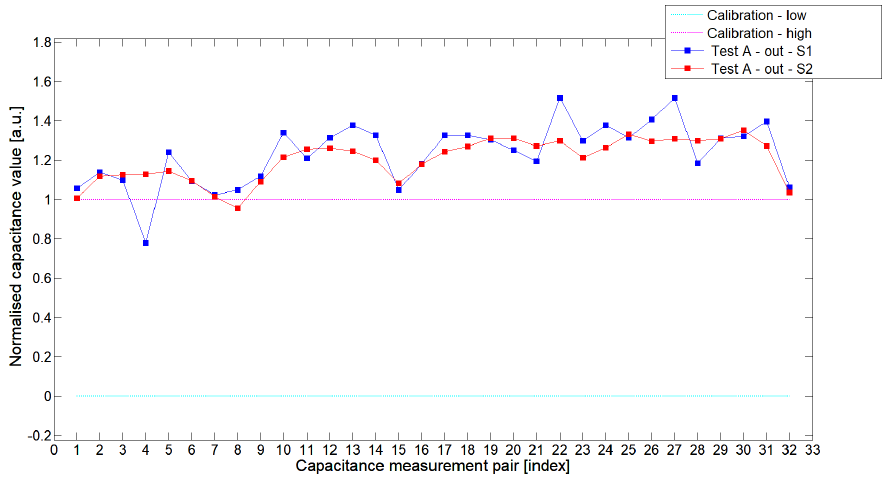
Figure 9. The 1st electrode measurement cycle (S1: 1->32 and S2: 1->32) for Test A out and S1—blue line, S2—red line. Cyan and magenta lines indicate calibration limits (0;1).